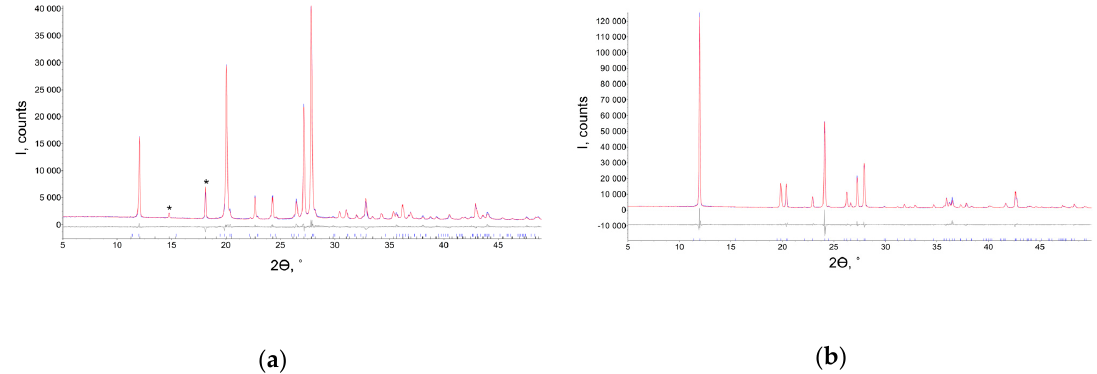
Figure 1. Powder XRD patterns for new tetragonal ( a ) and orthorhombic ( b ) forms of favipiravir. Experimental (blue), calculated (red) and their difference (grey) curves are depicted. The asterisks denote characteristic peaks of the new tetragonal form (111 and 112 reflections).